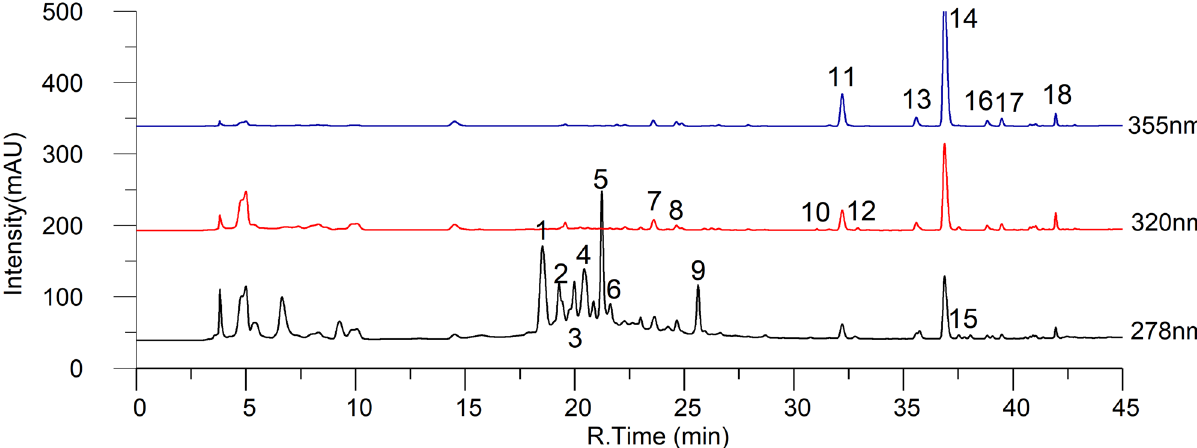
Figure 8. The HPLC chromatograph of phenolic profiles (FS at stage